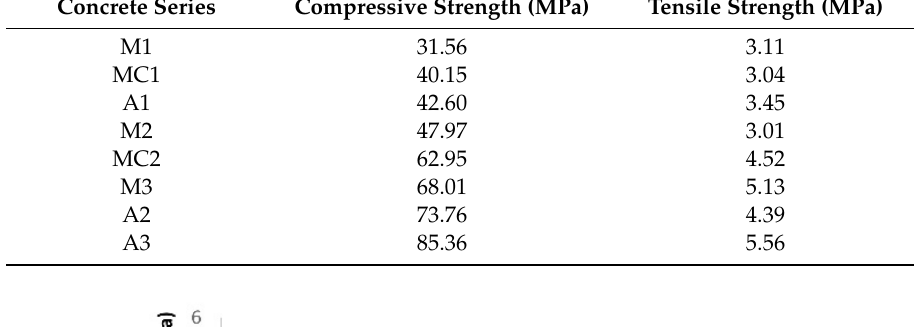
Table 6. Average compressive and tensile strengths for different concrete series.